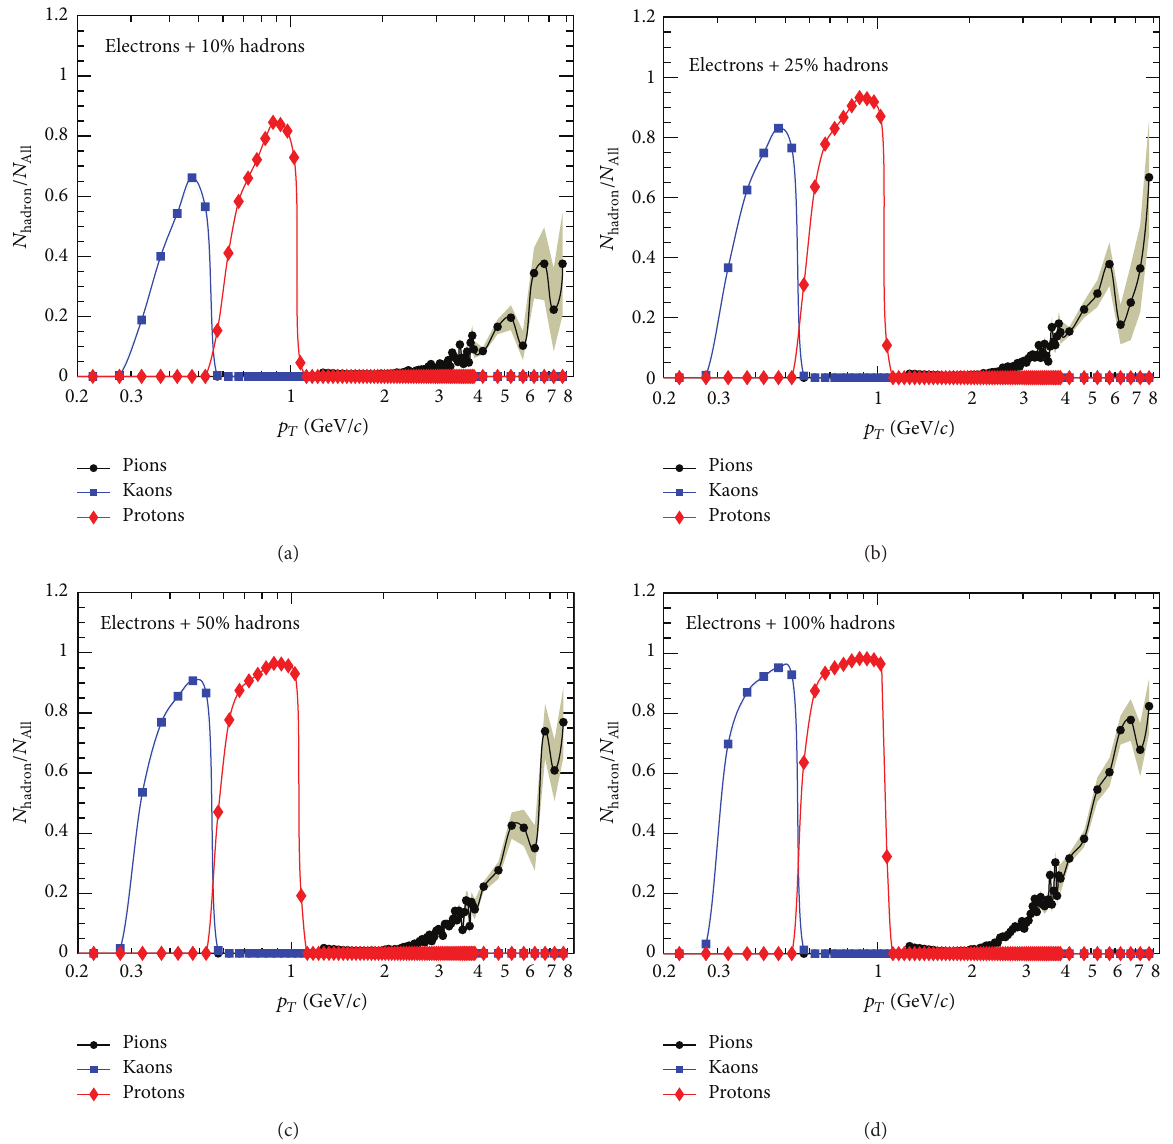
Figure 3: Relative hadron contributions to inclusive samples in the analysis for different hadron misidentification